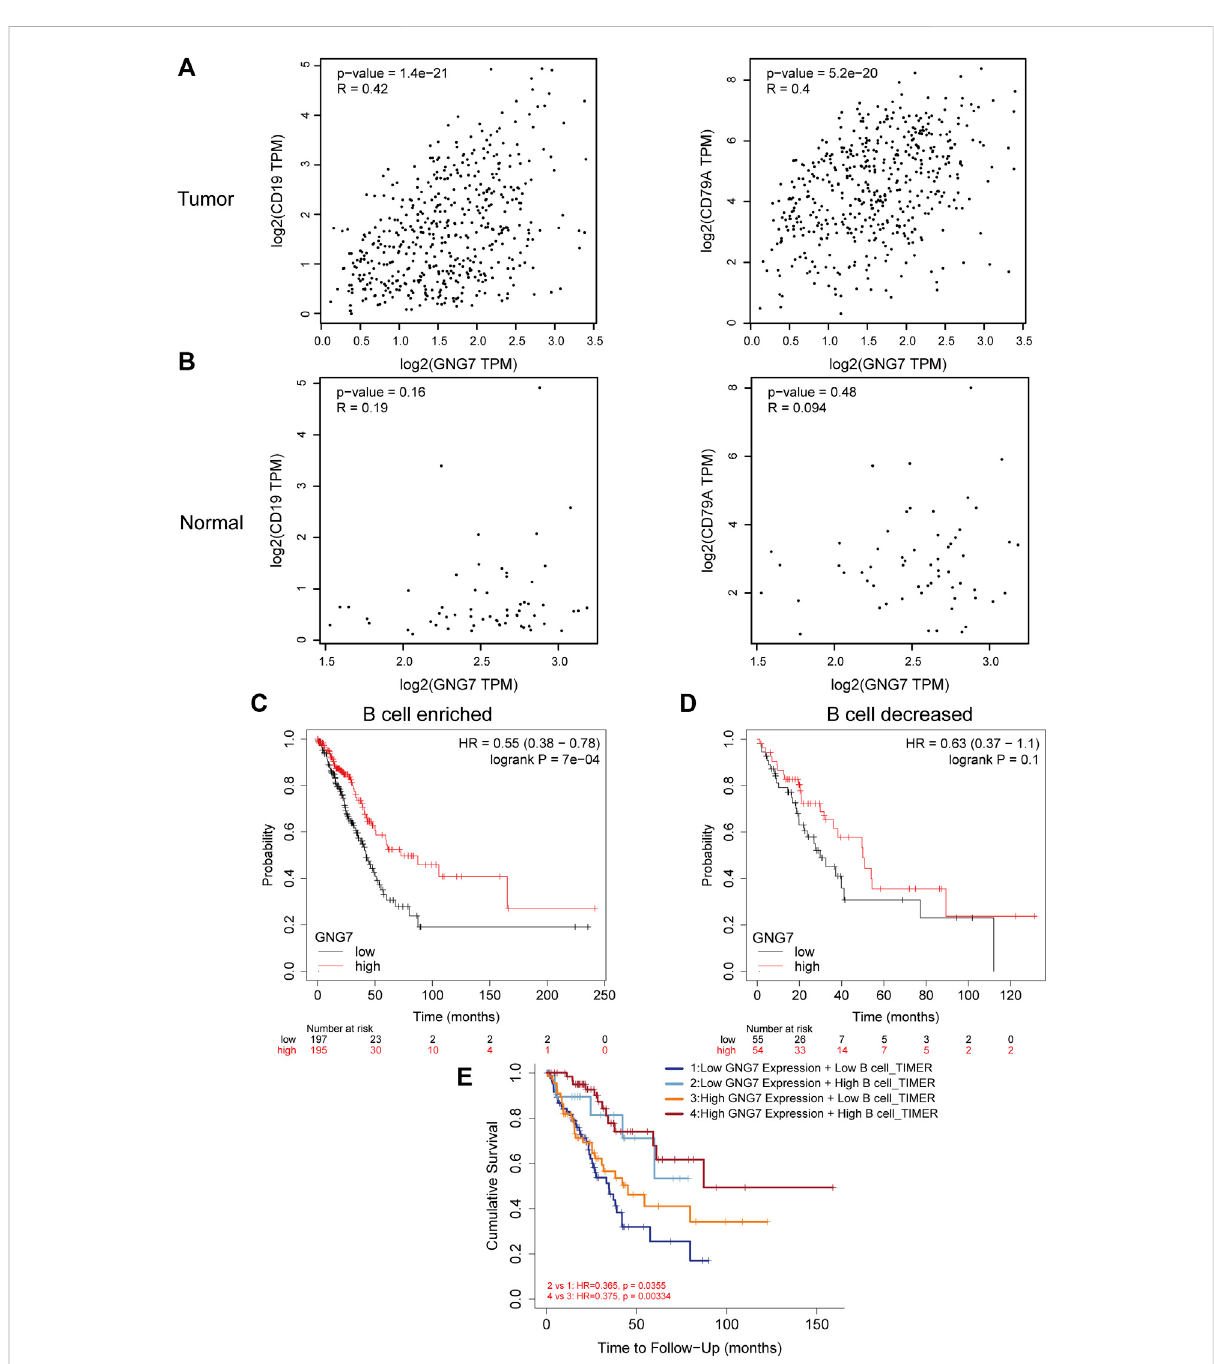
FIGURE 7 Correlation between GNG7 and B cell immune in fi ltration and prognostic analysis in LUAD. (A) The correlation between the expression of GNG7 and B cell markers CD19 (left) as well CD79A (right) in LUAD tissues. (B) The correlation between the expression of GNG7 and B cell markers CD19 (left) as well CD79A (right) in normal lung tissues. (C) Kaplan-Meier survival curves of OS in LUAD based on GNG7 expression in the enriched B cells groups. (D) Kaplan-Meier survival curves of OS based on GNG7 expression in the decreased B cells groups. (E) Kaplan-Meier survival curves of OS in LUAD based on B cell in fi ltration level in GNG7-high and -low expression patients. LUAD, lung adenocarcinoma; OS, overall